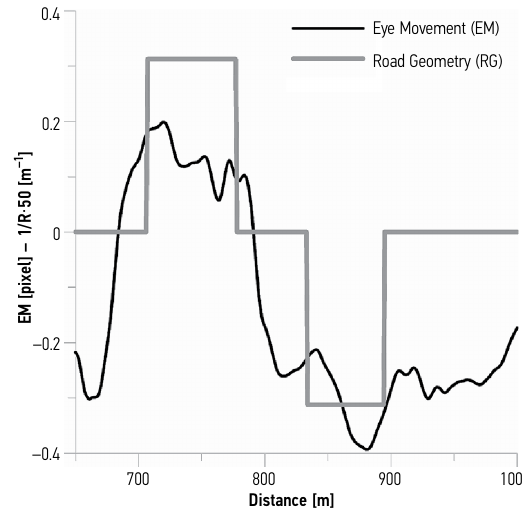
Fig. 6. Comparison of the Eye Movement (EM) function with the Road Geometry (RG) in the section 650÷1000 m